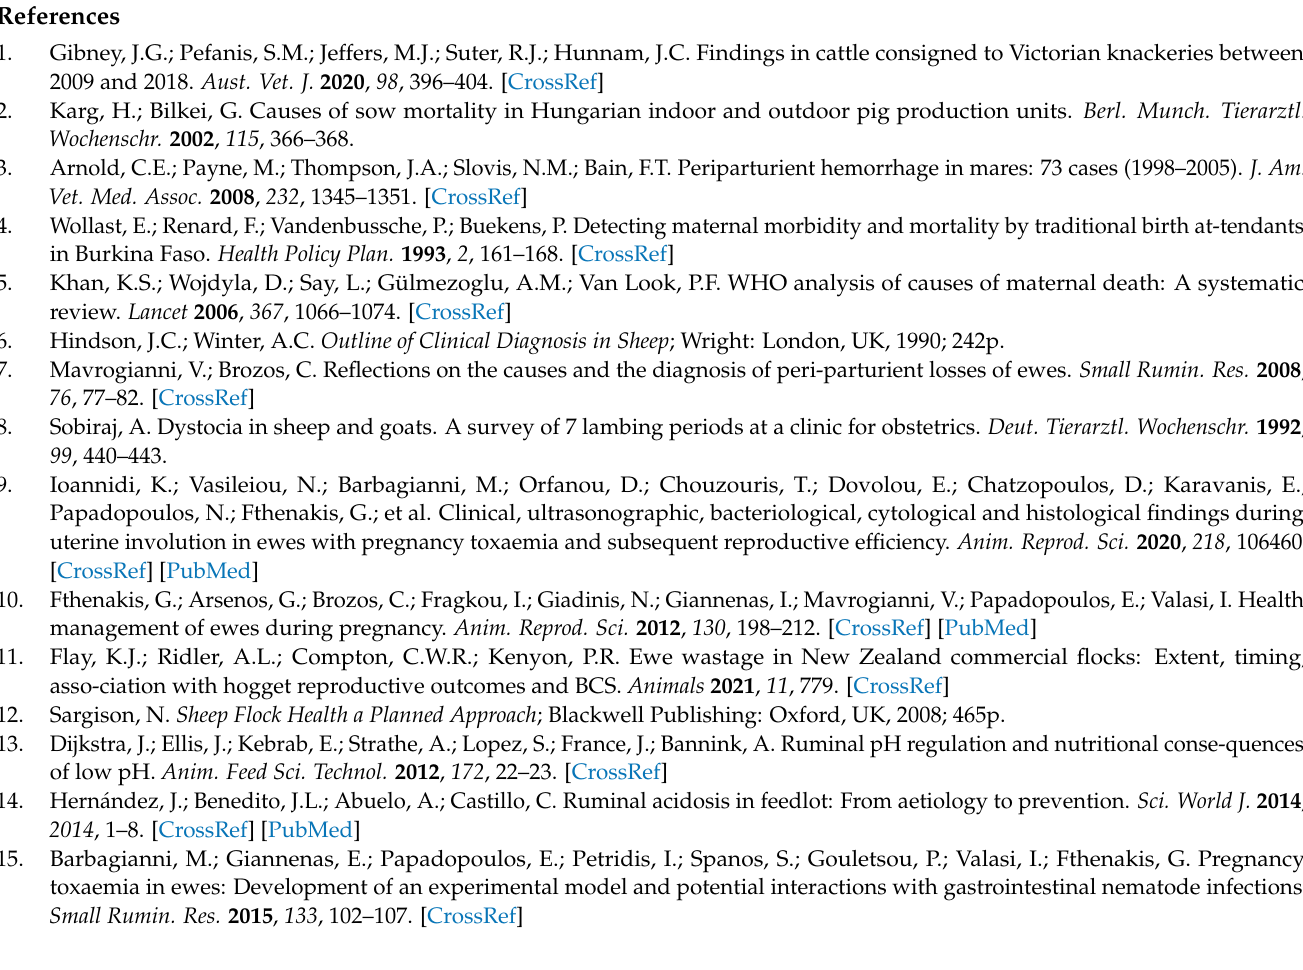
Table A2. Cont. Intramammary administration of antibiotics at the end of the previous lactation period Yes No n = 21 n = 39 Nutritional modifications performed during the last stage of pregnancy Yes No n = 28 n = 32 Administration of anthelmintics at the end of pregnancy Yes No n = 60 n = 0 Administration of anti-clostridial vaccination at the end of pregnancy Yes No n = 60 n = 0 Administration of anti-mastitis vaccination at the end of pregnancy Yes No n = 25 n =